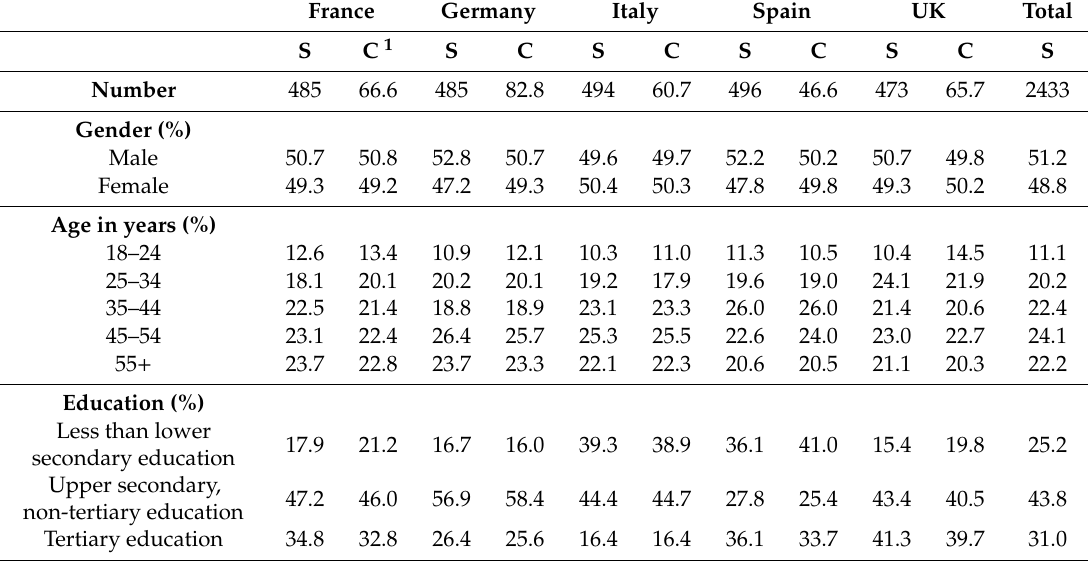
Table 3. Sample (S) and national census (C) socio-demographic